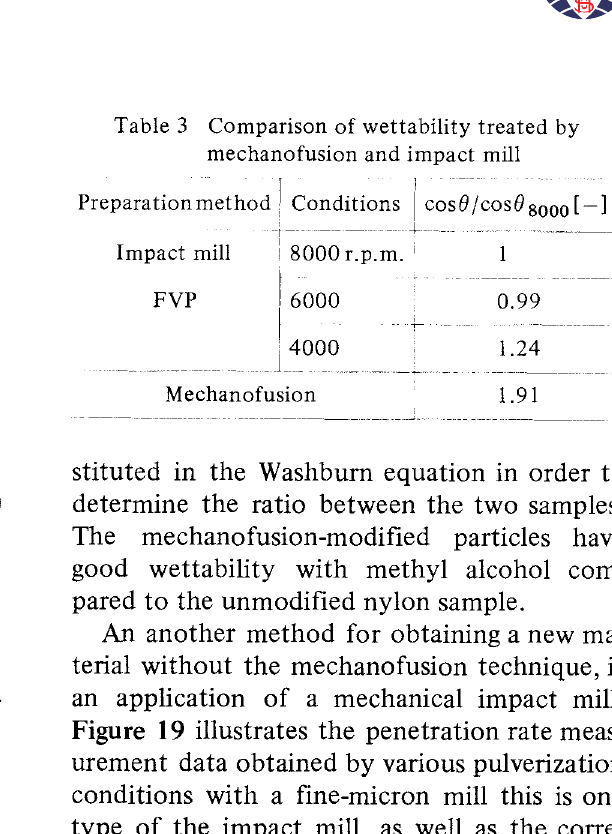
Table 3 Comparison of wettability treated by mechanofusion and impact